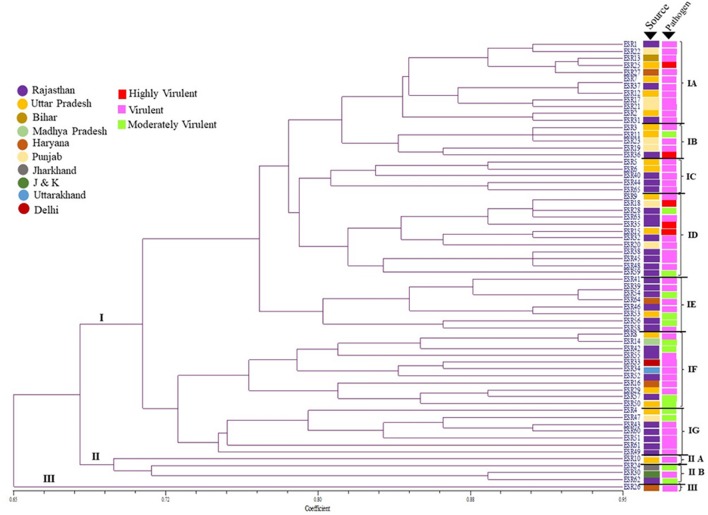
Dendrogram derived from the morphological characters of 65 different S. sclerotiorum isolates, based on growth, color, texture, shape and size of the mycelia and sclerotia grown on PDA medium and their respective pathogenicity over Brassica species.